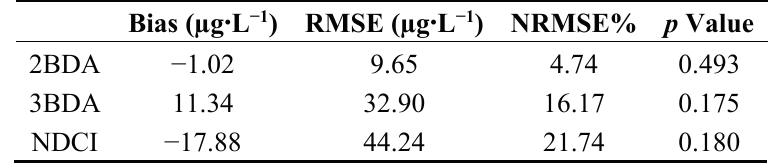
Table 7. Summary results for validation process applied to all samples using the hyperspectral